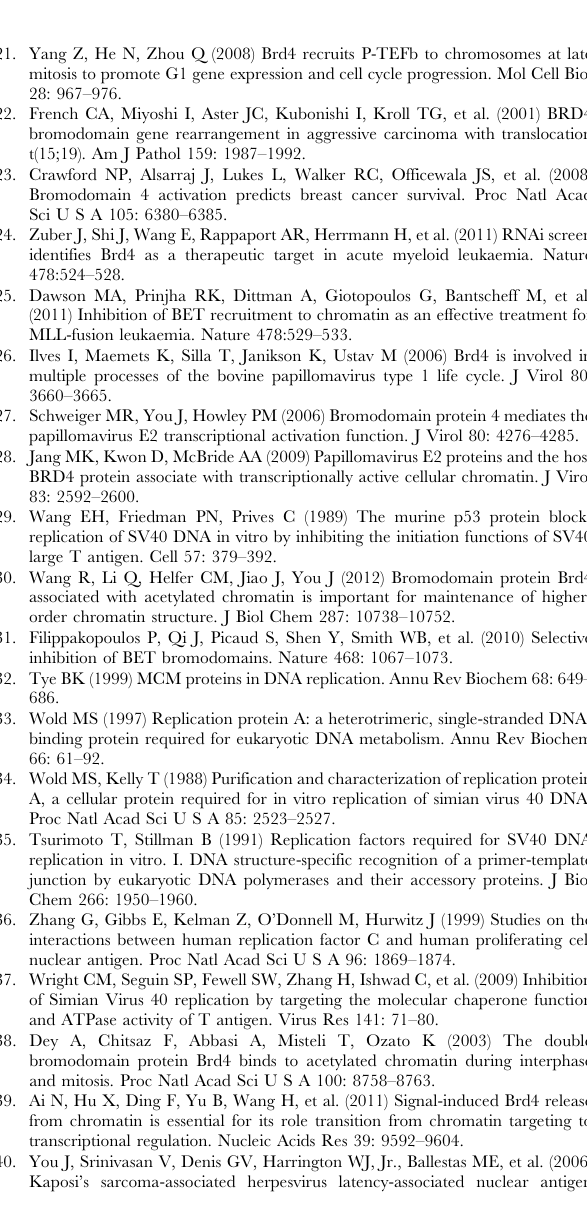
Figure S8 Brd4 471-730 ameliorates the cytotoxicity of MCV LT. 293T cells were co-transfected with either pOZN (grey) or pOZN-MCV LT (white) together with pcDNA4C (Vector) or pcDNA4C-Brd4 471-730. Cells were counted at 48 h p.t. and normalized to the number obtained from cells co-transfected with pOZN and pcDNA4C. Figure S9 Brd4 interacts with RFC1 but this interaction is not mediated by the DNI region of Brd4. 293T cells were co-transfected with an RFC1 expression plasmid and either a pOZN construct encoding a FLAG-HA tagged Brd4 truncation mutant or the FLAG-HA vector alone. Nuclear extracts IPed with anti-FLAG beads were immunoblotted with HA and RFC1 antibodies. (PDF) Text S1 This section provides a more detailed descrip- tion of the protocols, experimental procedures